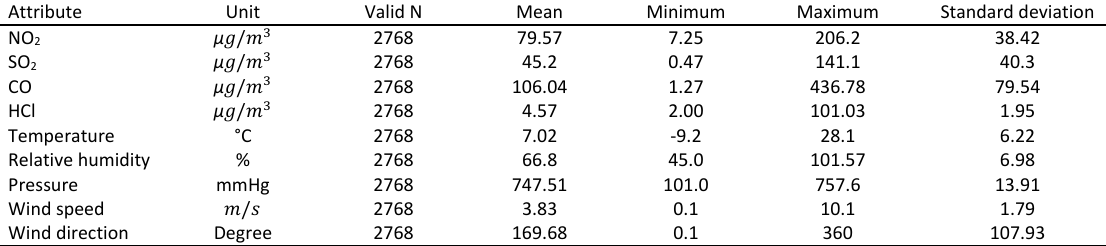
Table 1: Descriptive statistics of air pollutants and meteorological parameters